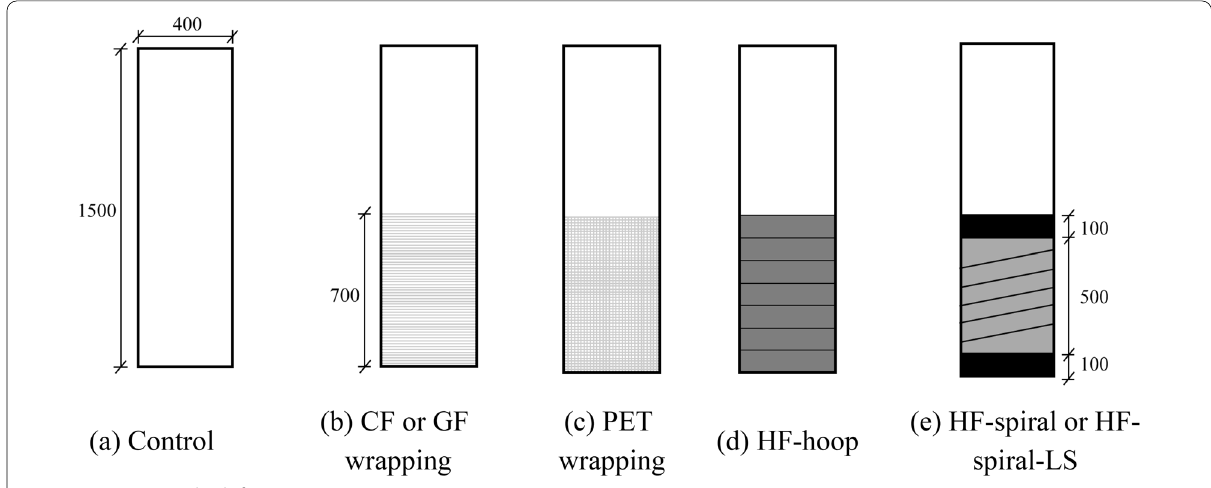
Fig. 2 Wrapping methods for specimen (Note: unit is in